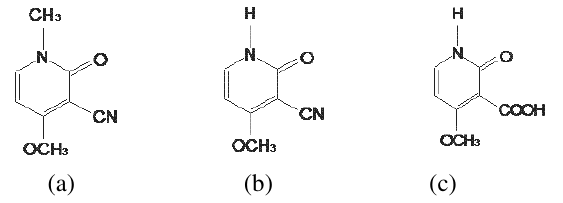
Figure 1. Chemical structure of the isolated